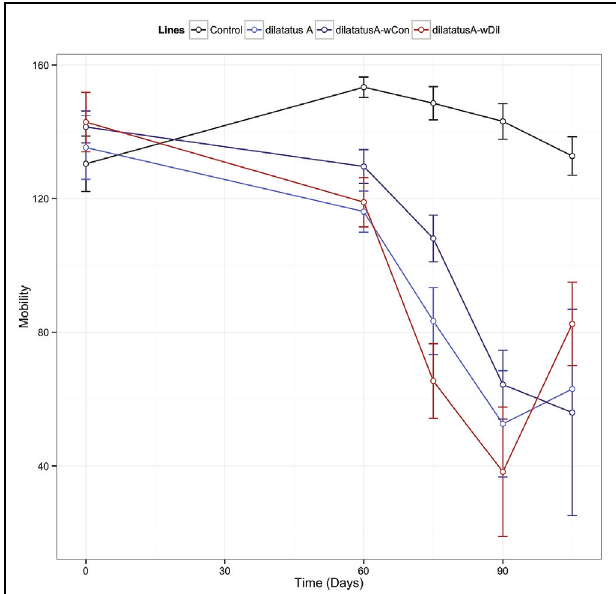
FIGURE 8 | Influence of resident Wolbachia on the mobility of P. dilatatus infected with w VulC. P. dilatatus males were injected with pathogenic w VulC Wolbachia strain and their mobility was recorded every 15 days. The mobility test was performed measuring the time the animals move in a Petri dish during a period of 180 s. Data points indicate the mean ( ±